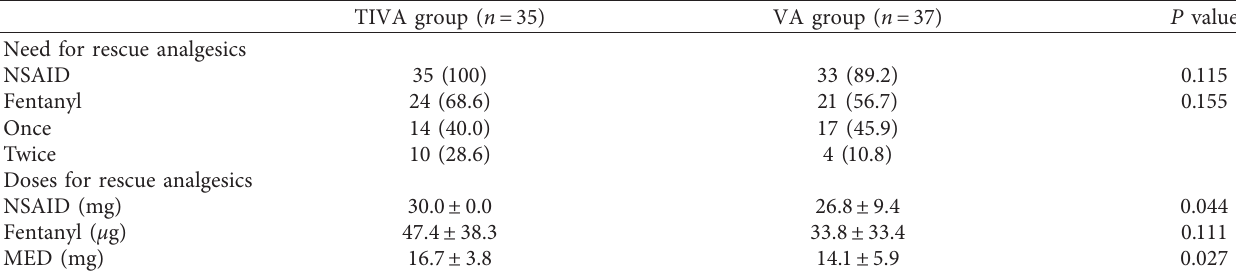
Table 2: Demands for rescue analgesics administered intravenously during stay at the postoperative anesthetic care unit.